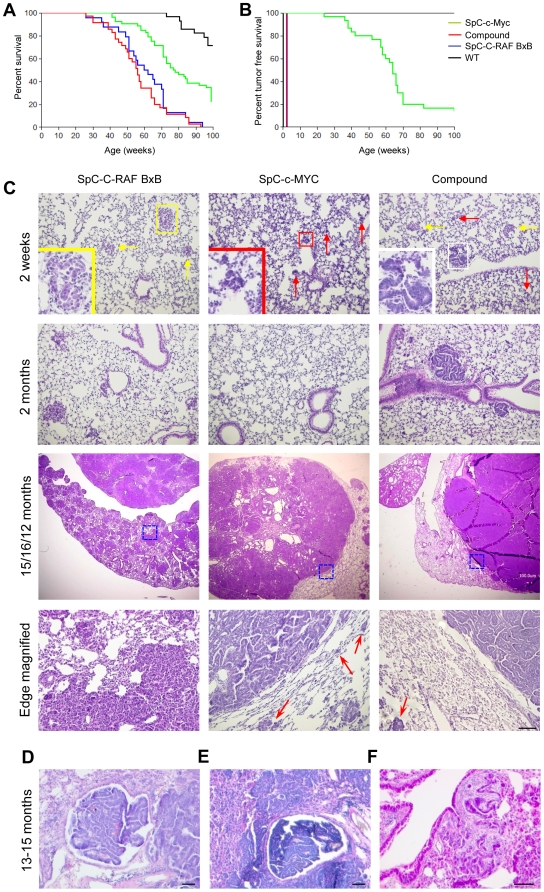
c-MYC cooperates with C-RAF in tumor growth.(A) Kaplan-Meier plot for SpC-C-RAF BxB (n = 24), SpC-c-MYC (n = 52), compound (n = 35) and wild-type (n = 28) littermate control mice. Log-rank analysis for percent survival for compound mice vs SpC-C-RAF BxB = p>0.05; SpC-C-RAF BxB vs SpC-c-MYC = p<0.0001; compound mice vs SpC-c-MYC = p<0.0001. n: number of animals. (B) Tumor incidence in SpC-C-RAF BxB (n = 51), SpC-c-MYC (n = 30), compound mice (n = 109) and wild-type littermate control mice (n = 58). Log-rank analysis for tumor free survival for SpC-C-RAF BxB vs SpC-c-MYC = p<0.0001; compound mice vs SpC-c-MYC = p<0.0001; wild type vs SpC-c-MYC = p<0.0001. n: number of animals. (C) Kinetics of tumor progression. Representative lung tumour sections stained with haematoxylin and eosin (H&E). The yellow box and arrows highlights cuboidal cell adenoma (inset) in SpC-C-RAF BxB mice; the red box and arrows indicates pleomorphic cells (inset) in SpC-c-MYC mice and the white boxes show a columnar cell adenoma (inset) in compound mice. For evaluation of invasiveness at the tumour-stroma interface, the boxed areas of the third panel are magnified in the bottom panel. Genotypes and ages of mice as indicated. Isolated small tumor cell clusters around the main tumor were indicated with red arrows. Scale bar: 100 µm. (D, E) H&E staining of paraffin embedded lung sections from compound (D) and SpC-c-MYC single transgenic (E) mice showing papillary tumors in bronchioles. Age of mice as indicated. (F) Desmoplastic progression of lung tumors from a compound mouse. Age of mice as indicated. Scale bar, 100 µm.